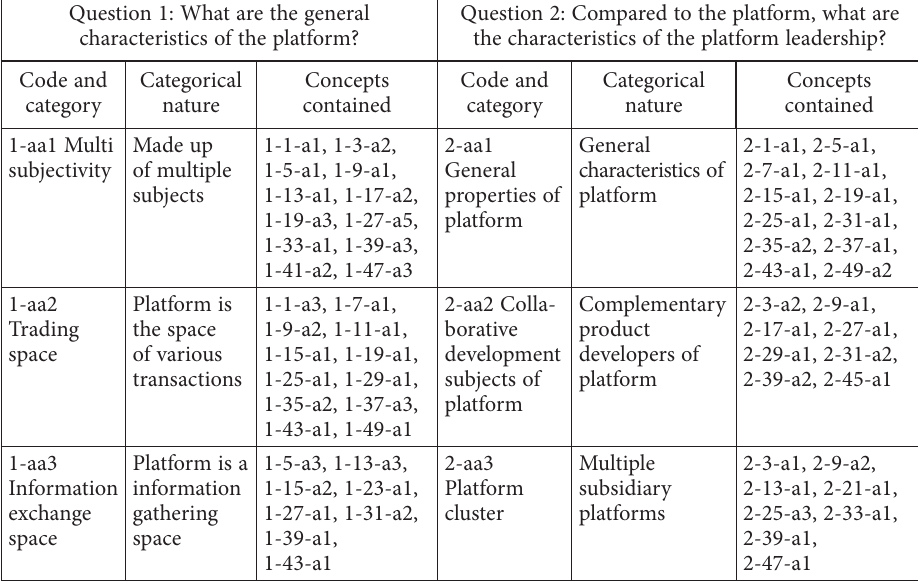
Table 2. Categories which are formed by the open coding Question 1: What are the general Question 2: Compared to the platform, what are characteristics of the platform? the characteristics of the platform